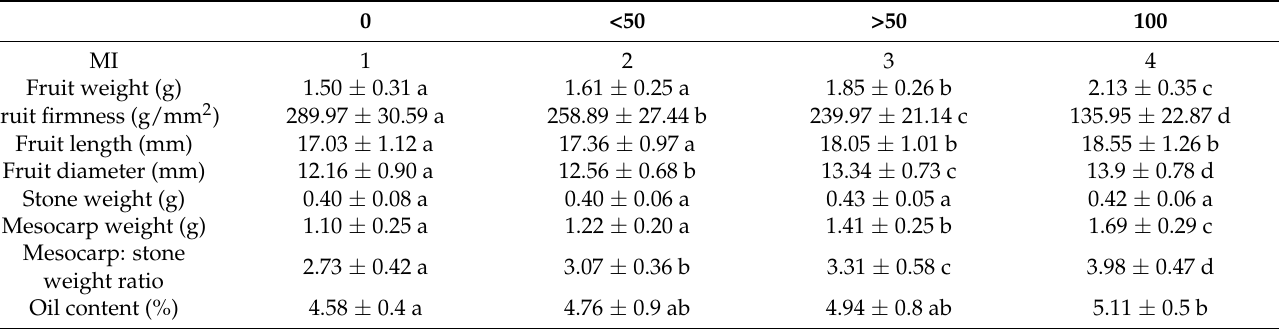
Table 1. Fruit characteristics (fruit, mesocarp and stone weight, fruit firmness, fruit diameter and length, mesocarp:stone weight ratio) of olive fruits of the cultivar ‘Leccino’ at different ripening stages, MI and oil content of